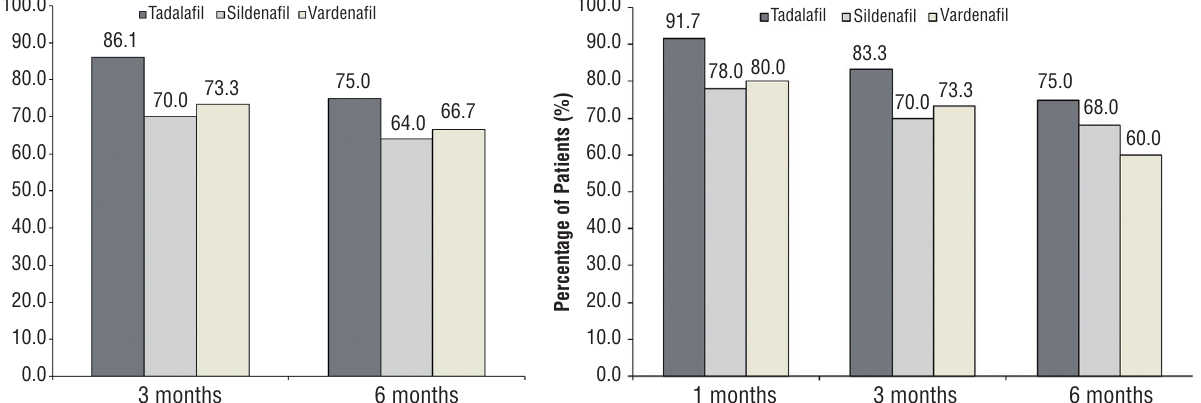
Figure 1 - Treatment persistence and adherence by treatment group for sildenafil, tadalafil, and vardenafil. A) Treatment persistence by treatment group at 3 and 6 months, B) Treatment adherence at 1, 3, and 6